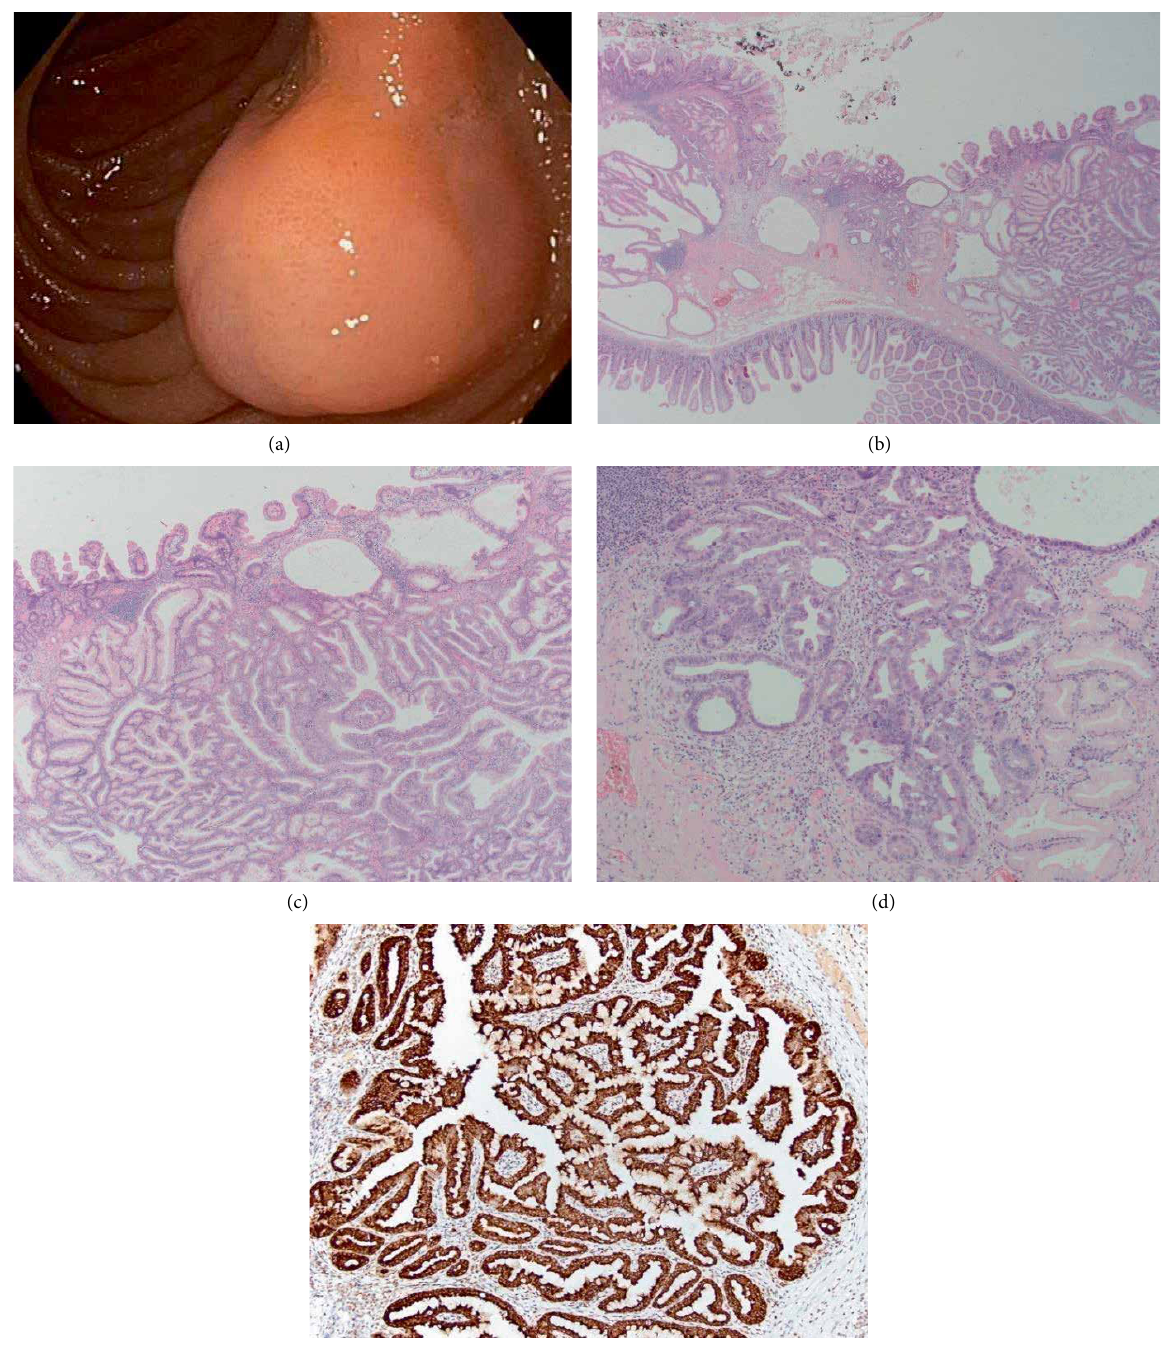
Figure 1: Macroscopic and microscopic views of the duodenal adenocarcinoma. (a) Appearance of the lesion on endoscopy showing central depression but otherwise unremarkable overlying mucosa. (b) Low power . Microphotography of the duodenal lesion with an inverted pattern of growth and normal appearing overlying mucosa. (c) Medium power . Microphotography of the duodenal lesion shows tightly packed tubules consistent with pyloric gland origin. (d) Medium power . Focus of the invasive duodenal adenocarcinoma with cytological atypia, nuclear pleomorphism, and increased nuclear to cytoplasmic ratio consistent with malignancy. (e) Medium power . Immunohistochemistry of the duodenal lesion shows extensive positive staining for gastric-type mucin MUC6, a marker consistent with pyloric gland